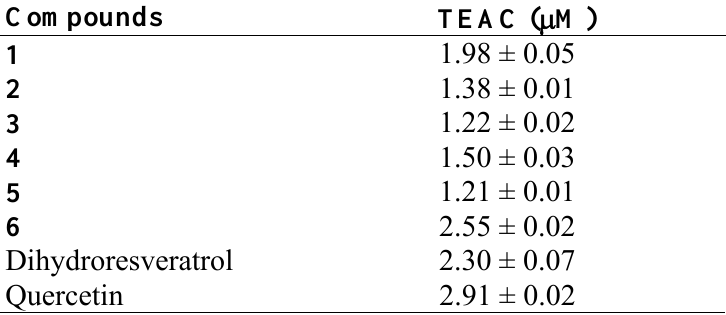
Table 3. TEAC values for compounds 1 - 6 of N. nivea .